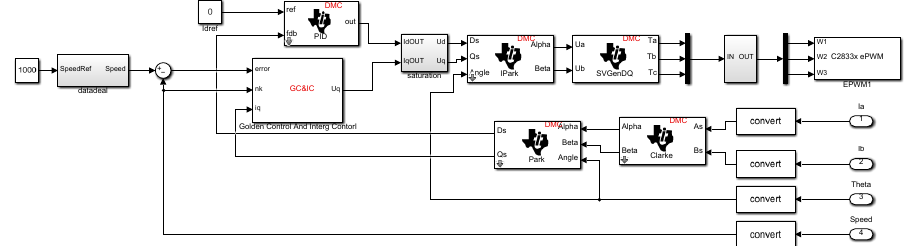
Figure 7. DSP automatic code generation model for FOC system.